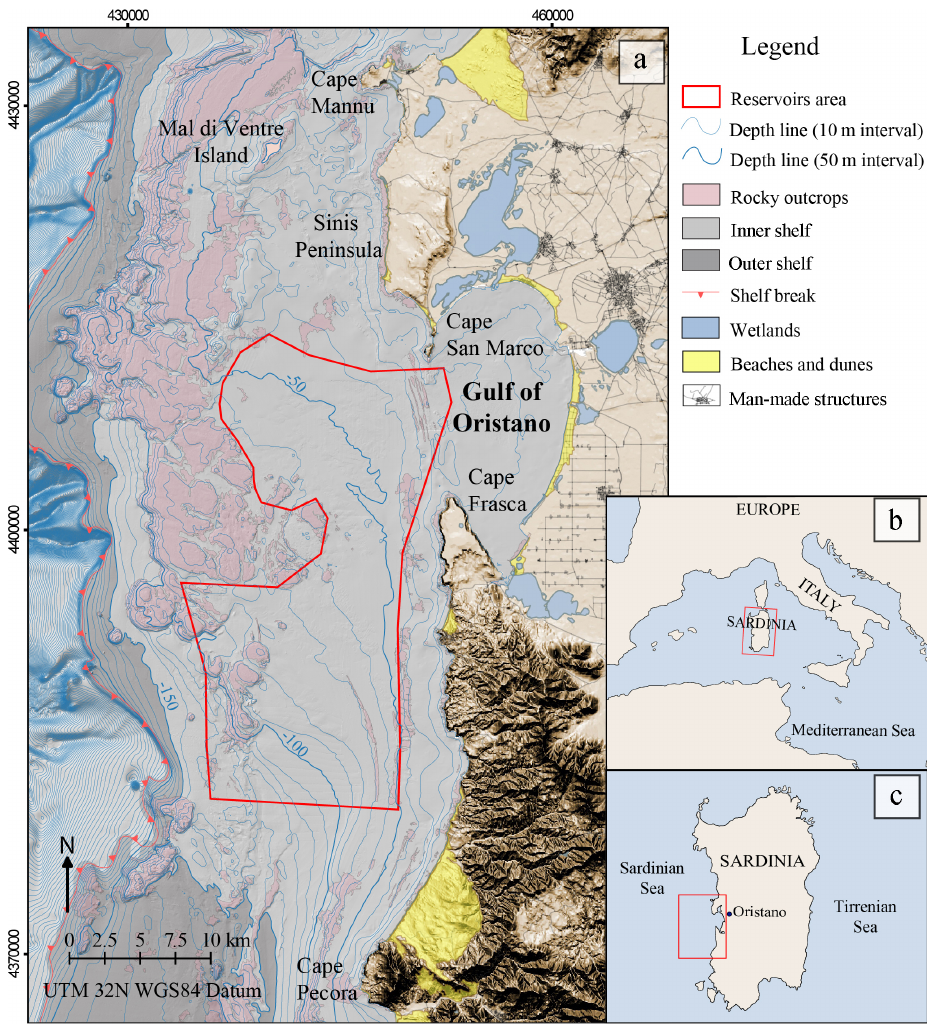
Figure 1. (a) Location of the study area and schematic geomorphological map; (b) geographic surroundings of the study area; (c) regional